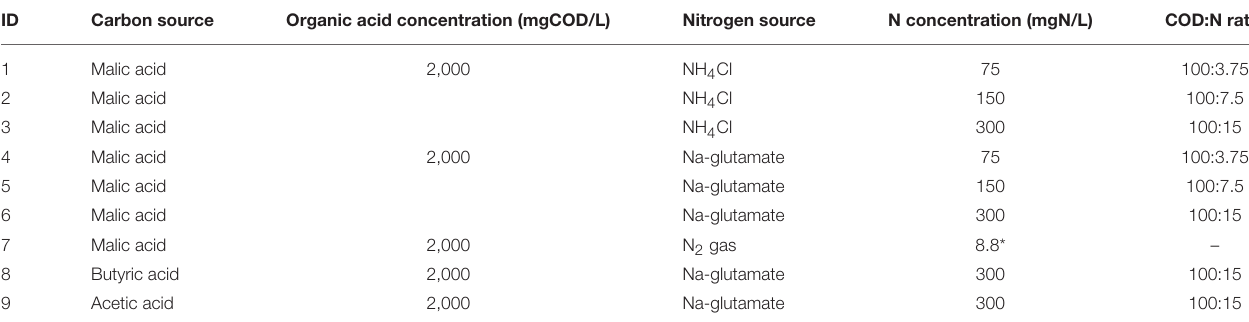
TABLE 1 | Experimental runs of PPB biological experiments under different nitrogen and carbon sources.